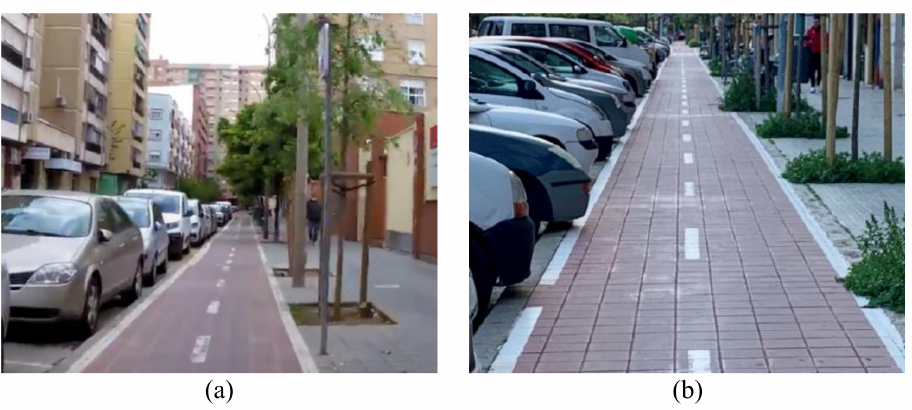
Figure 6. Sidepath without physical or vegetated curb next to parked motorized vehicles: ( a ) parallel parking, and ( b ) perpendicular